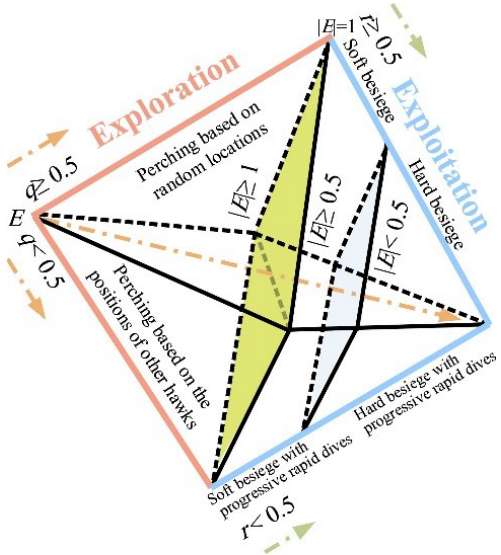
Figure 4. All phases of Harris hawk optimization algorithm